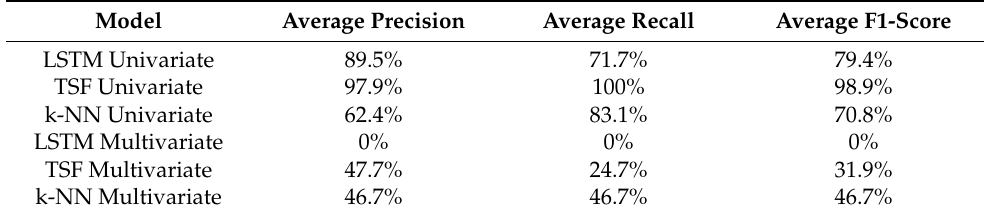
Table 14. Performance Parameters for OC